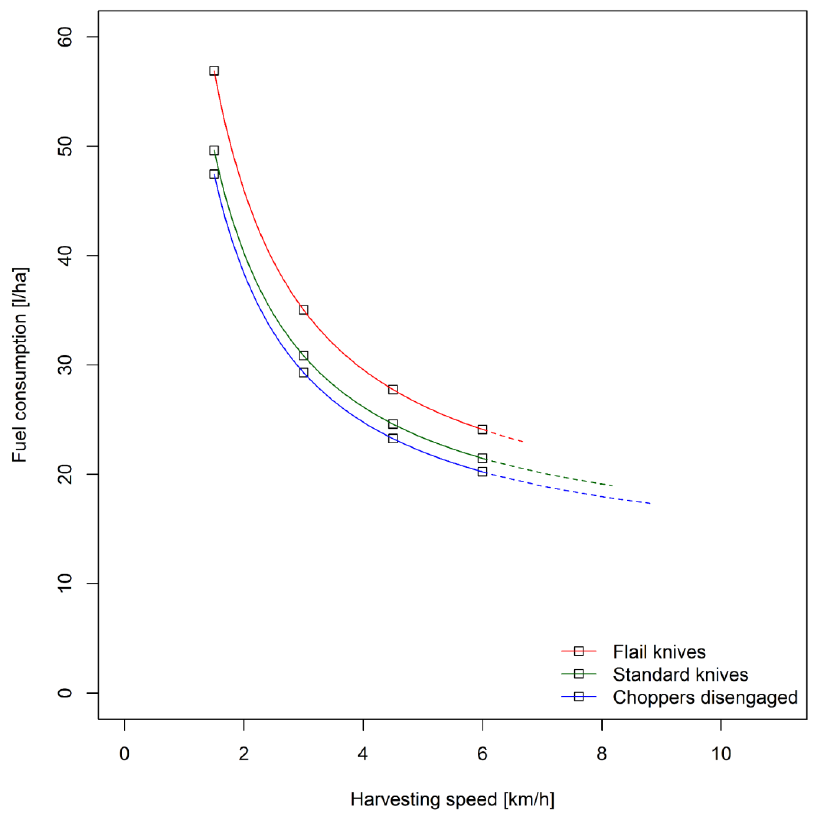
Figure 5. Fuel consumption of the combine harvester depending on harvesting speed for the levels of corn header configuration at cutting height level 1 (Markers indicate harvesting speed levels at cutting height level 1). Table 3. Harvestingspeed, powerconsumptionofthecornheader, areaperformanceandfuelconsumption for three different corn header configurations at 90% engine load of the combine